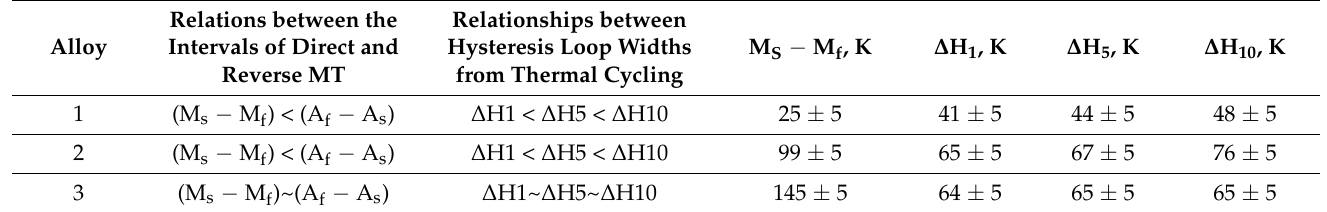
Table 5. Relations between MT intervals and the width of hysteresis loops from thermal cycling (where 1, 5, 10 is the number of cycle).